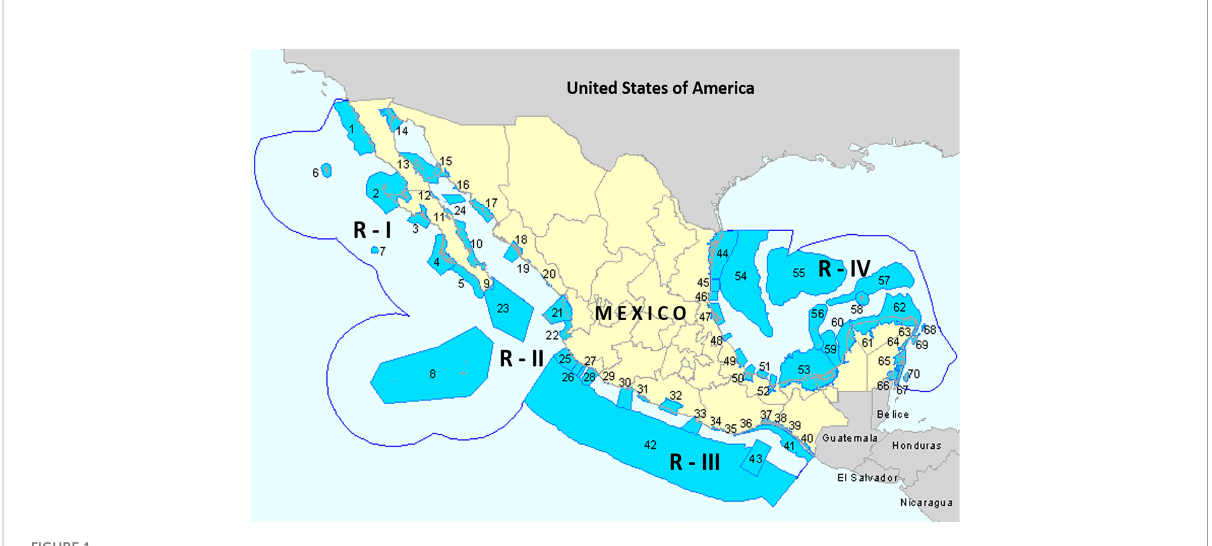
FIGURE 1 Coastal and marine priority regions in Mexico. Modi fi ed from Arriaga Cabrera et al.